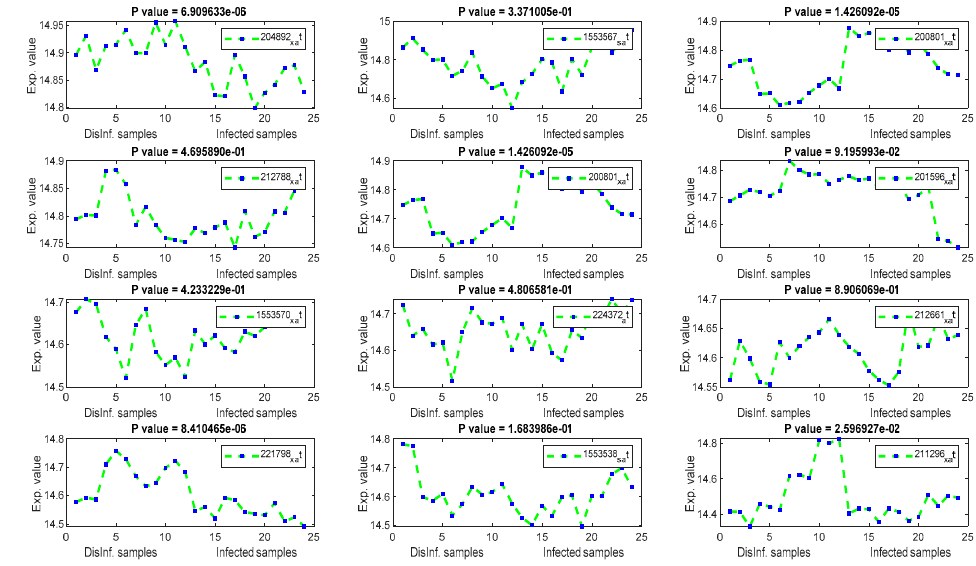
Figure 7. The gene signal profiles of top ranked key genes retrieved using PCA.